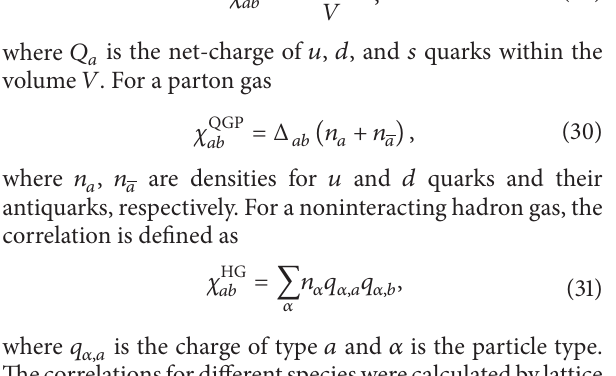
Figure 6: The balance functions in terms of Δ𝜙 for all charged particle pairs from Au+Au collisions at √𝑠 from